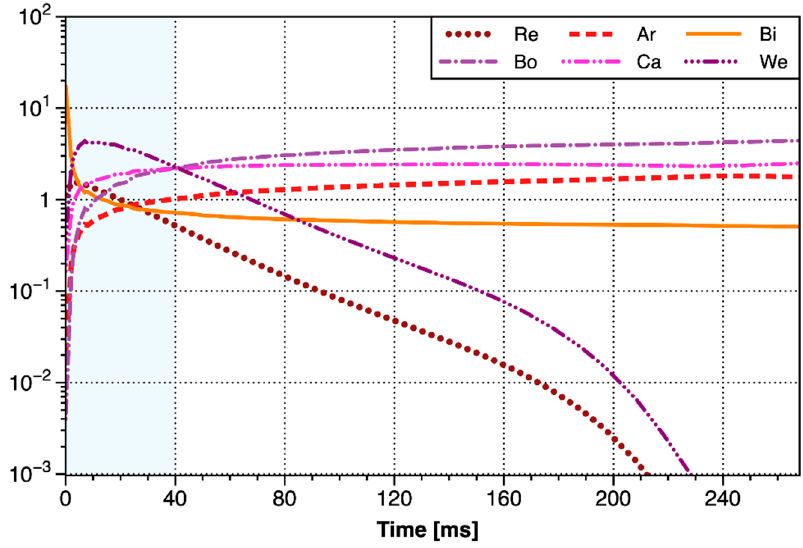
Figure 10. The curves of the dimensionless number of the major bubble with time.